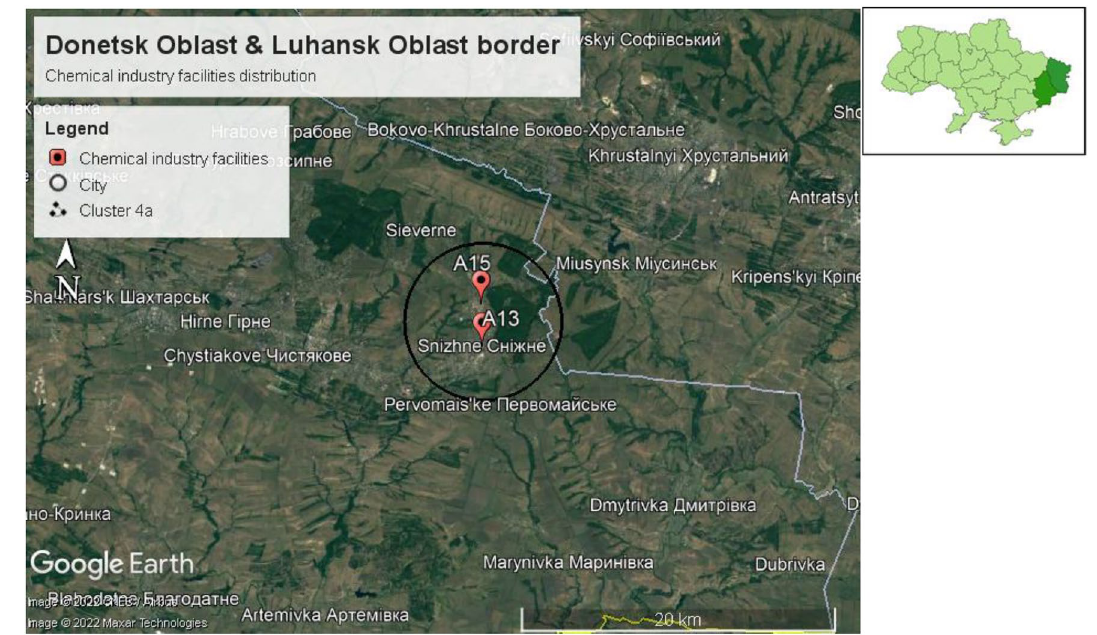
Figure 9. Cluster 4a located near the border of Luhansk